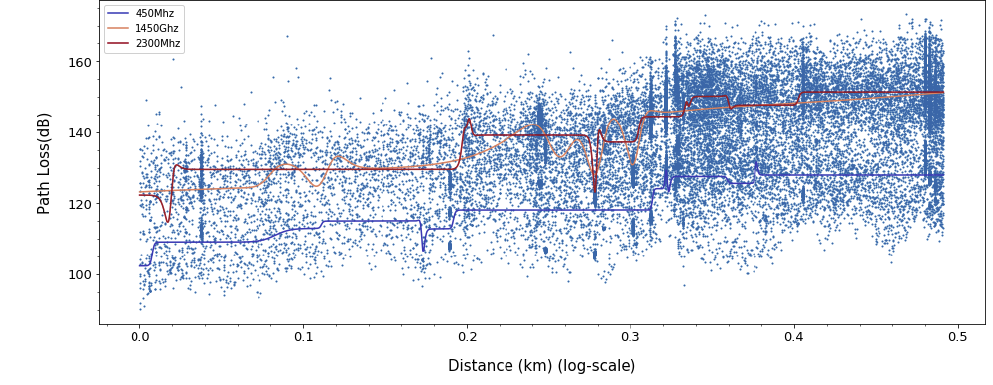
Figure 12. Path loss prediction based on ANN-MLP for 450, 1450, and 2300 MHz.